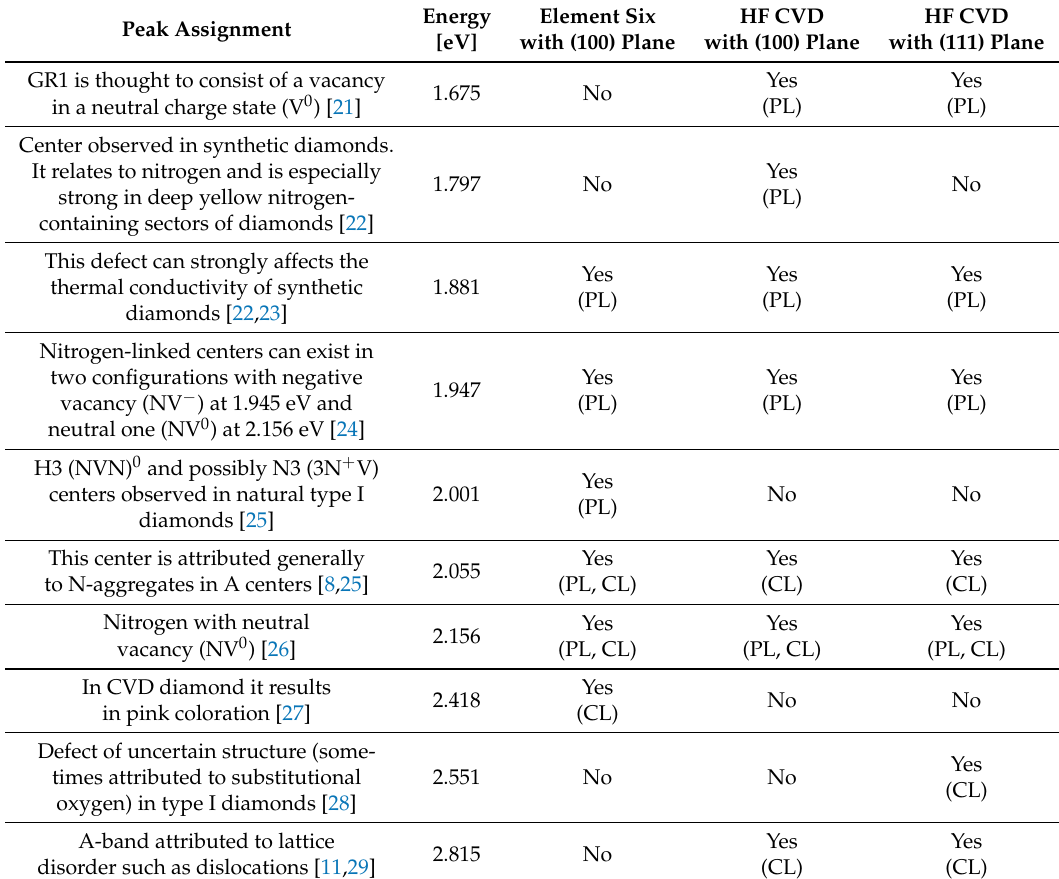
Table 1. The observed color centers in the CL and PL